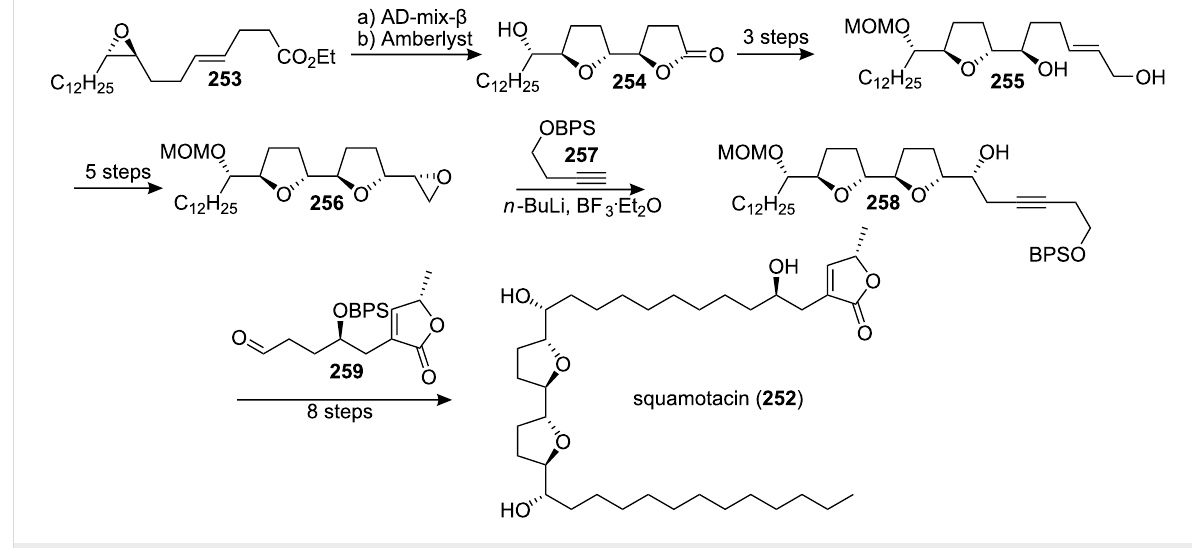
Scheme 35: Total synthesis of squamotacin by the group of Sinha and Keinan.